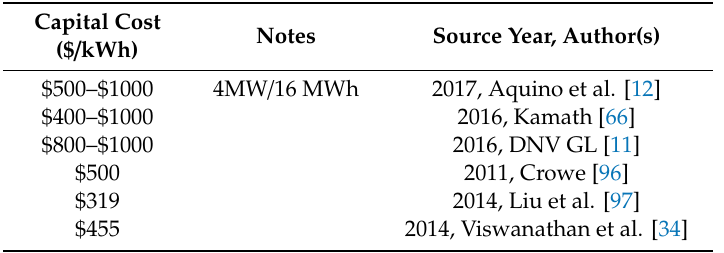
Table 19. Capital cost estimates—sodium-sulfur technology.